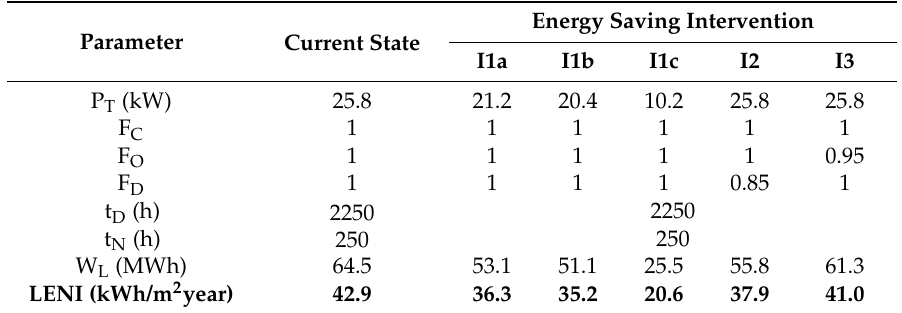
Table 3. Results of LENI evaluations for the current state and for the different energy saving interventions on the indoor lighting